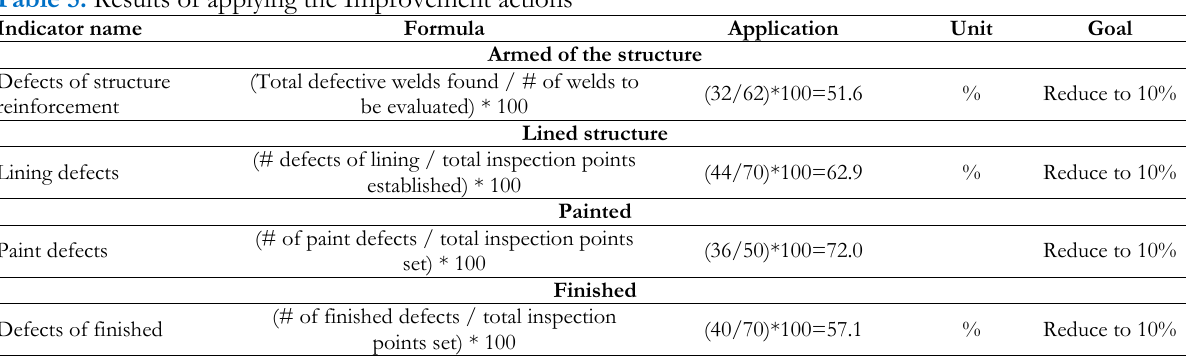
Table 5. Results of applying the Improvement